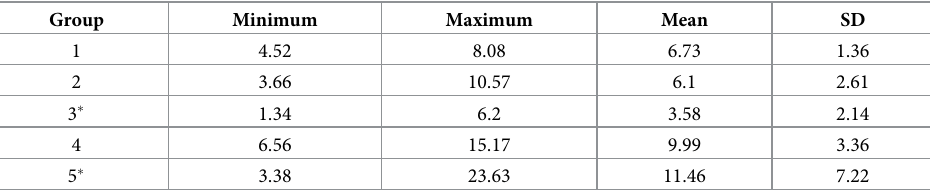
Table 2. Mean, standard deviation (SD), and range of shear bond strength values (MPa). Group